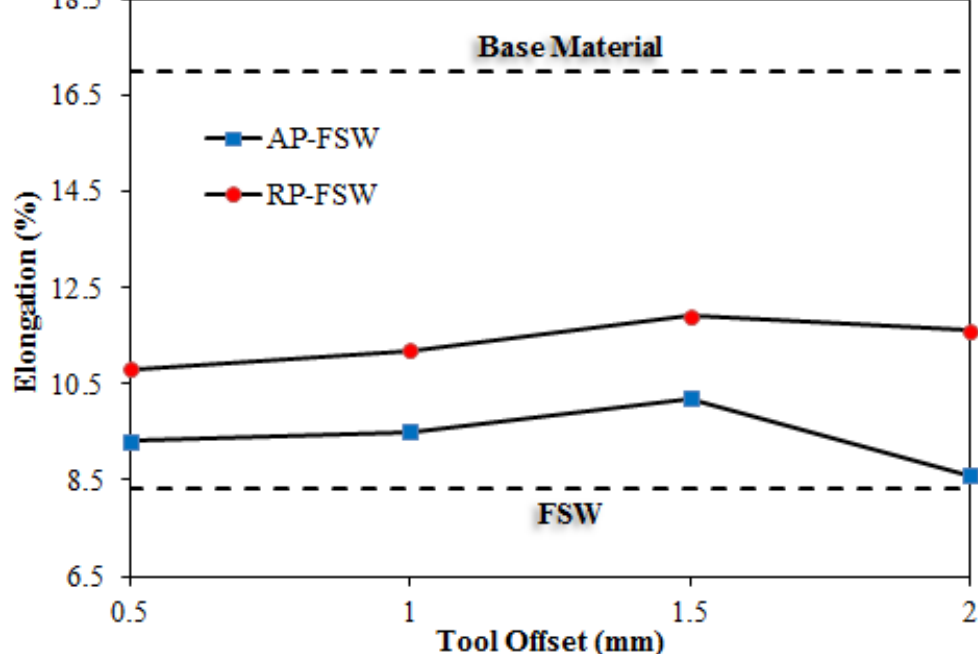
Figure 10. Comparison of E% values of welded specimens with FSW, AP-FSW, and RP-FSW tech- niques.